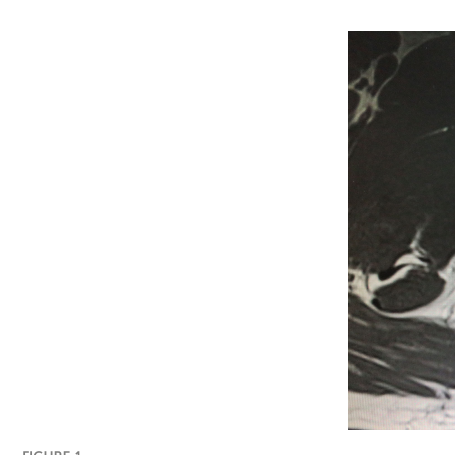
FIGURE 1 MRI revealed a perineal tumor. The arrow points out the location of the